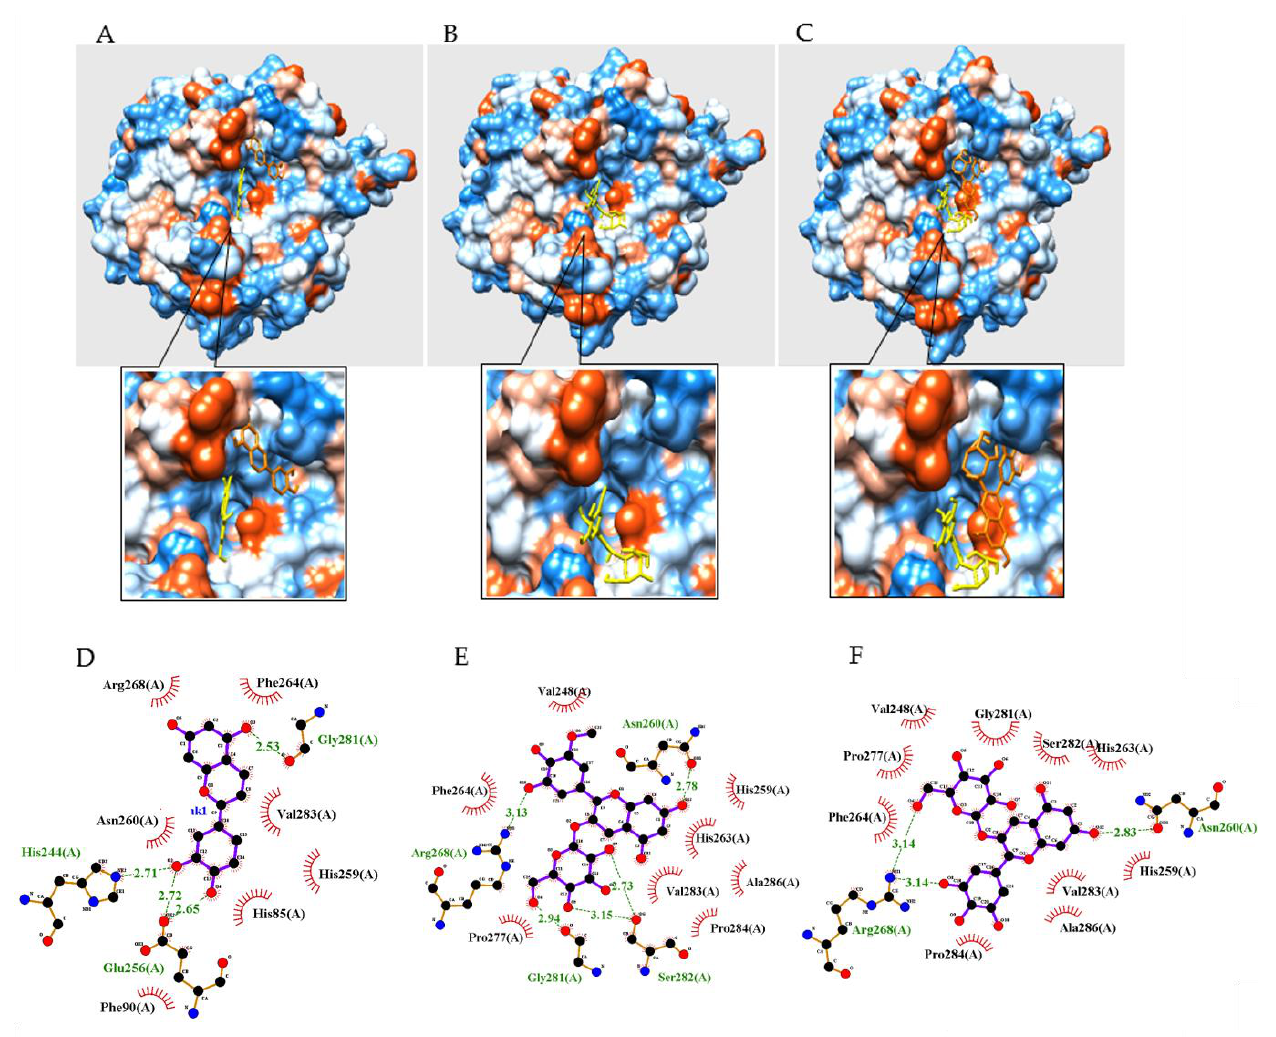
Figure 3. The best binding poses ( A – C ) of compounds 1 – 3 on tyrosinase (orange structure is best pose of cluster 1 of inhibitors 1 and 3 , and yellow structure is best pose of cluster 2 of inhibitors 1 and 3 , and cluster 1 of inhibitor 2 ). The green dotted line represents hydrogen bonds’ interaction between inhibitor 1 – 3 ( D – F ) and enzyme, respectively.